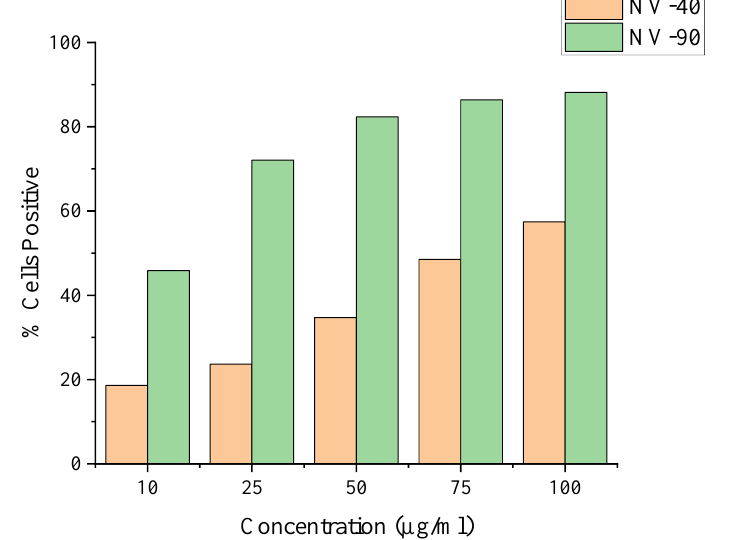
Figure 7. Comparison of the percentage of cells positive with various concentrations of NV-40 and NV-90 NDs. Fluorescence intensity was measured using the FL3 filter (670 LP), where 10,000 events were counted.